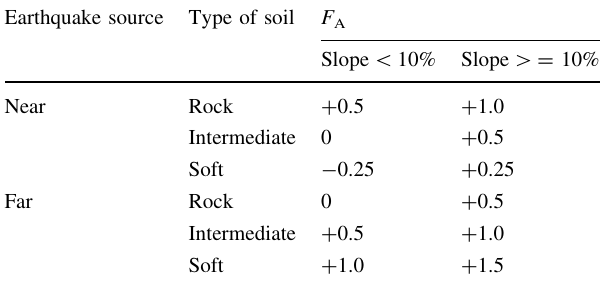
Table 6 Aggravation factor F A according to earthquake origin, soil type, and slope Earthquake source Type of